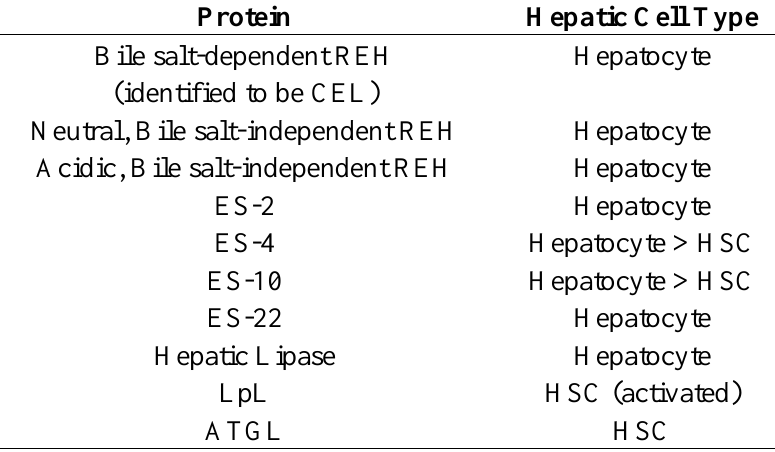
Table 2. Proposed Hepatic Retinyl Ester Hydrolases